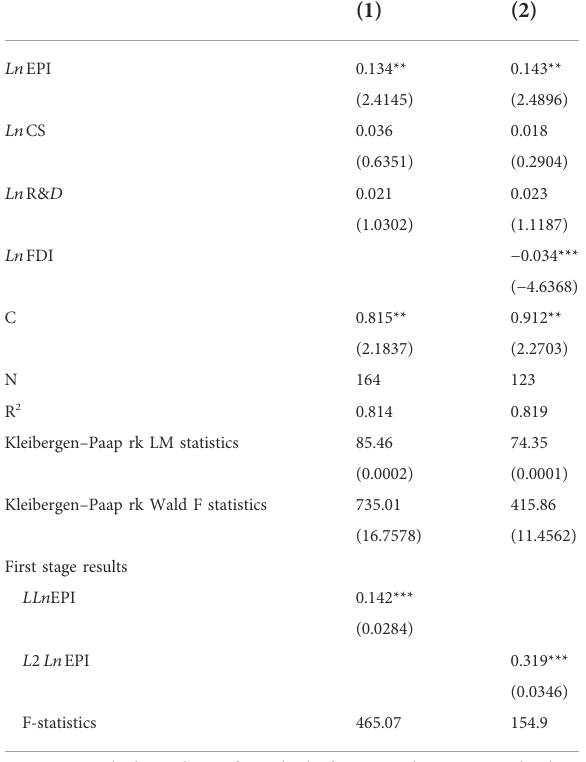
TABLE 7 Results of the 2SLS estimations for 41 major